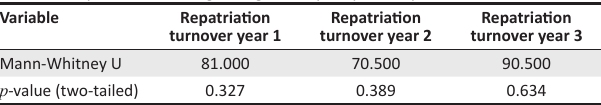
TABLE 9: Implemented foreign assignment policy and repatriation turnover rates. Variable